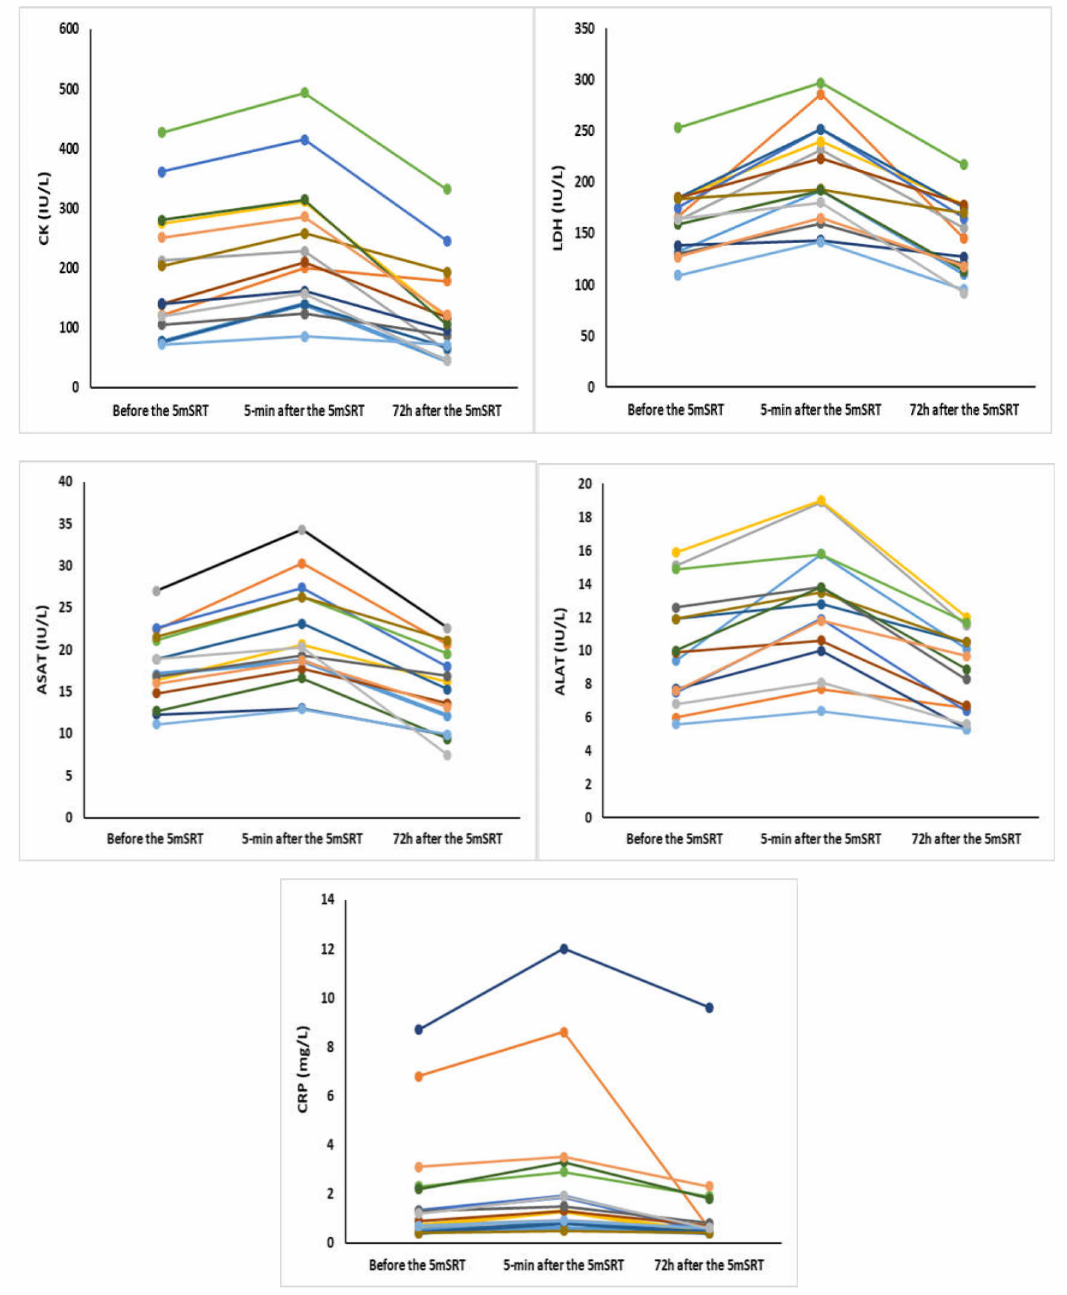
Figure 2. Biochemical parameters recorded before, 5 min and 72 h after the 5mSRT for all